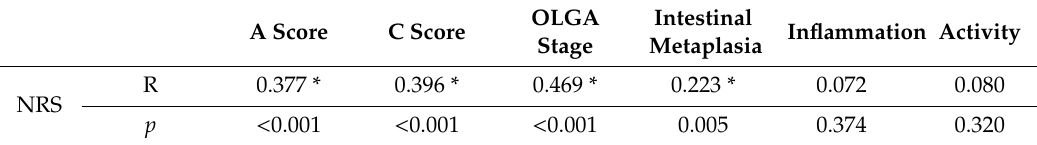
Table 1. Correlation analysis results between NRS and gastric parameters ( n = 155).